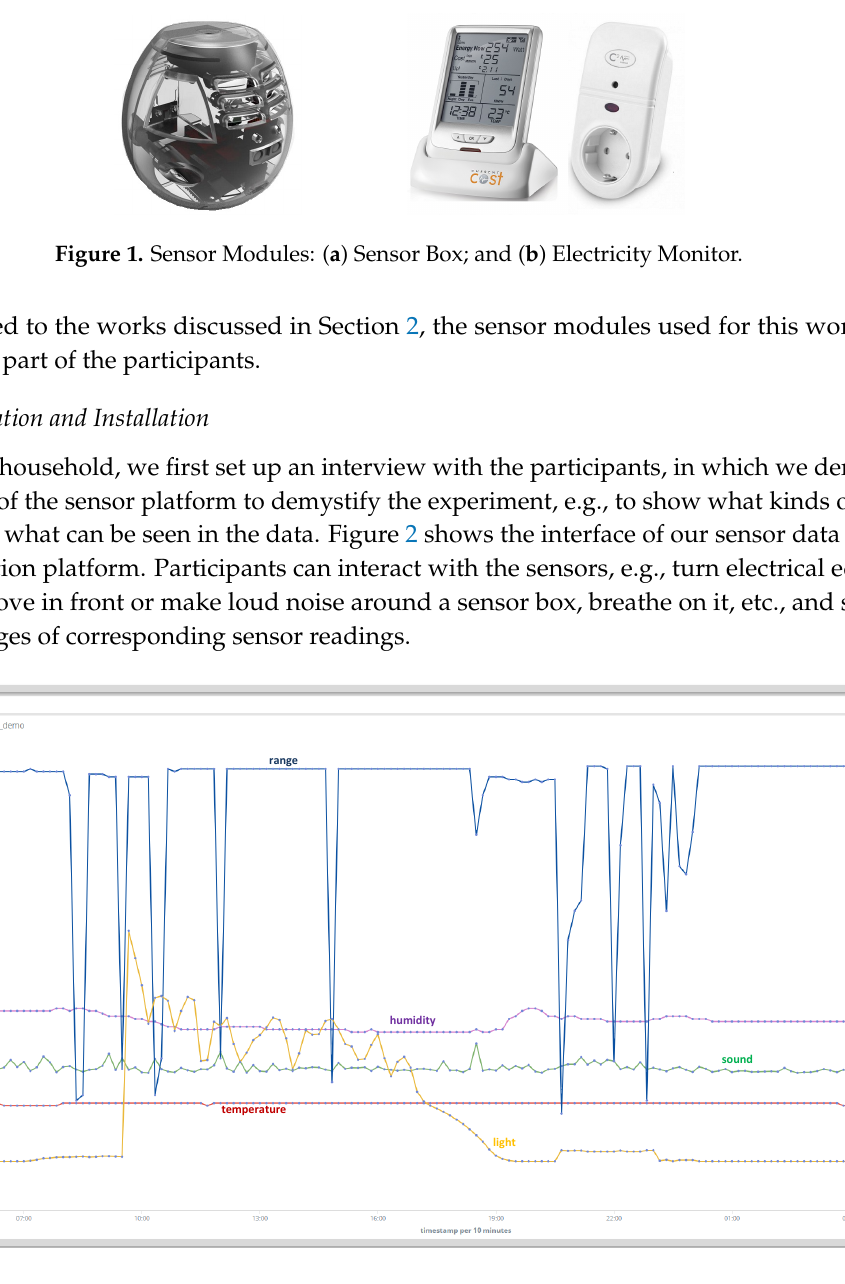
Figure 2. Demonstration